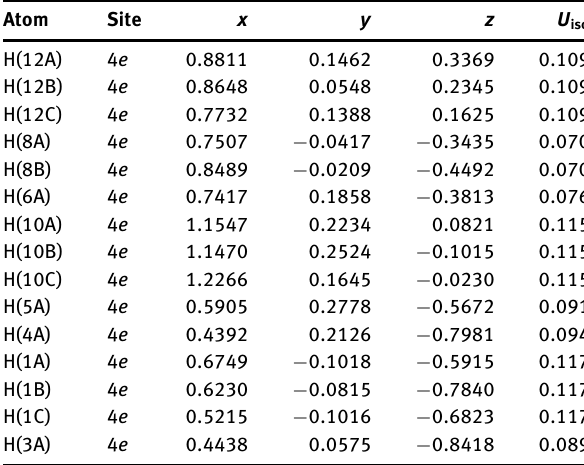
Table 2: Fractional atomic coordinates and isotropic or equivalent isotropic displacement parameters (Å 2